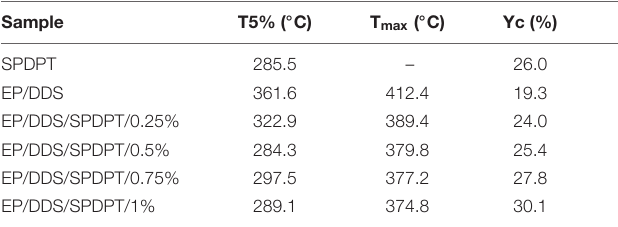
TABLE 3 | Thermal degradation characteristics of SPDPT and epoxy thermosets.